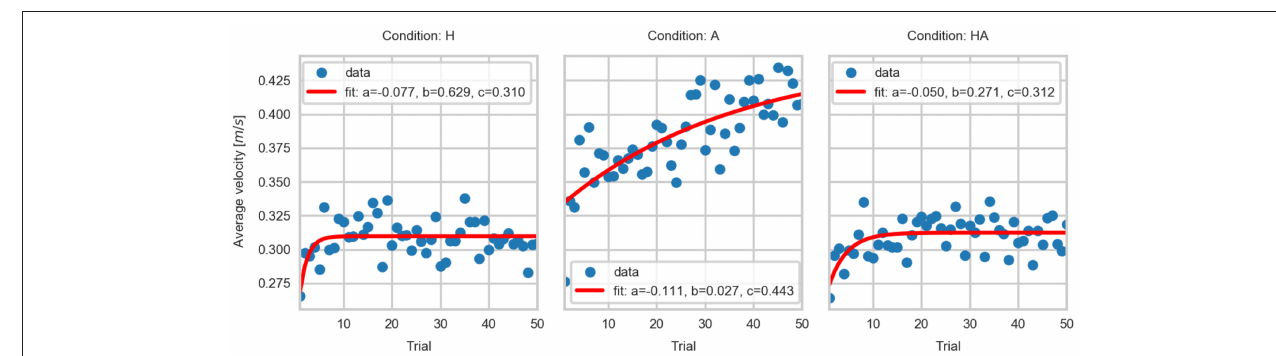
FIGURE 12 | Exponential fits to the average velocity data.